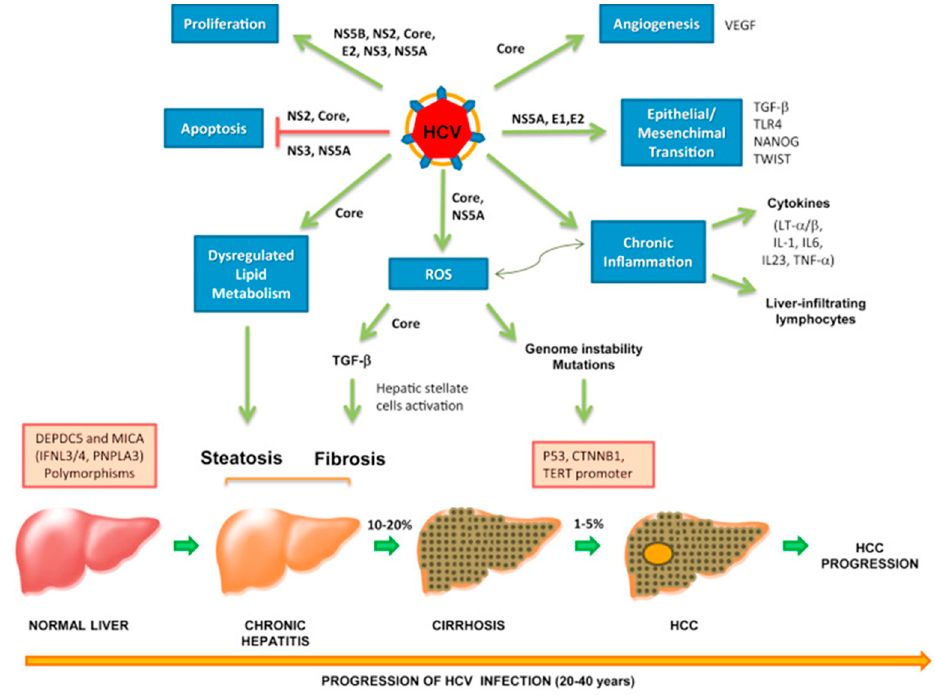
Figure 6. Hepatitis C virus (HCV)-related mechanisms of carcinogenesis: from HCV infection to hepatocellular carcinoma (HCC). Chronic HCV and associated liver cirrhosis represent major risk factors for HCC development. Hepatocarcinogenesis is a multistep process that may last for years; it involves progressive accumulation of different genetic alterations which lead to malignant transformation. Malignant transformation of hepatocytes occurs through increased liver cell turnover, induced by chronic liver injury and regeneration, in the context of inflammation and oxidative stress. HCV proteins may directly upregulate mitogenic pathways, block cell death and induce reactive oxygen species (ROS) production. Moreover, HCV triggers persistent inflammation with accumulation of liver-infiltrating lymphocytes and production of several cytokines, such as LT α and LT β , which are tightly linked to HCC development. Chronic inflammation exacerbates ROS production, which is considered a main source of genetic mutations. ROS are also associated with TGF- β pathway induction, leading to hepatic stellate cell activation and fibrogenesis. Transforming growth factor- β (TGF- β ), together with TLR4, plays an important role in the epithelial–mesenchymal transition. HCV dysregulates host lipid metabolism, causing liver fat accumulation which in many patients is associated with HCC. HCV is also able to induce angiogenic and metastatic pathways. Polymorphisms, mainly in DEPDC5 and MICA genes, have been recently shown to increase the risk of developing HCC. HCC, hepatocellular carcinoma; HCV, hepatitis C virus; ROS, reactive oxygen species; TGF, transforming growth factor. Reproduced with permission from Vescovo, T., Molecular mechanisms of hepatitis C virus–induced hepatocellular carcinoma; published by Clin. Microbiol. Infect. , 2016.